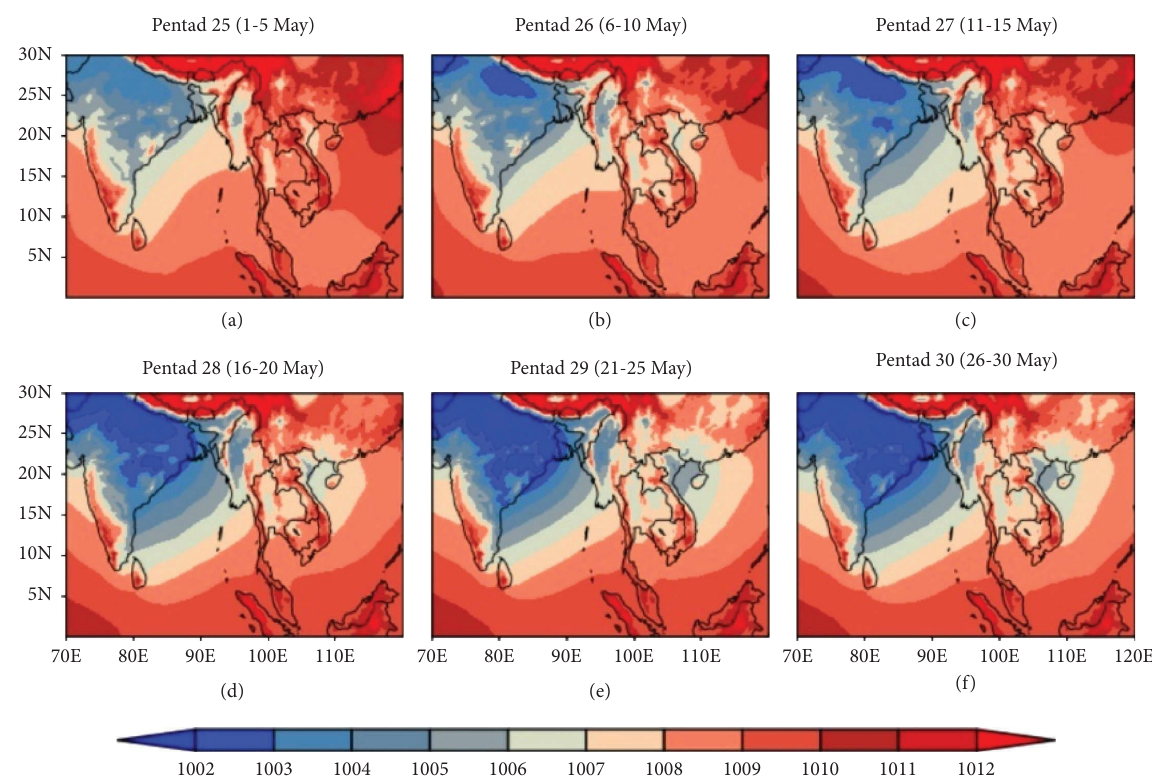
Figure 17: Composite of climatology (1991–2020) MSLP (hPa, colour) during the pentads: (a) P -25 (May 1–5), (b) P -26 (May 6–10), (c) P -27 (May 11–15), (d) P -28 (May 16–20), (e) P -29 (May 21–25), and (f) P -30 (May 26–30) during the monsoon onset